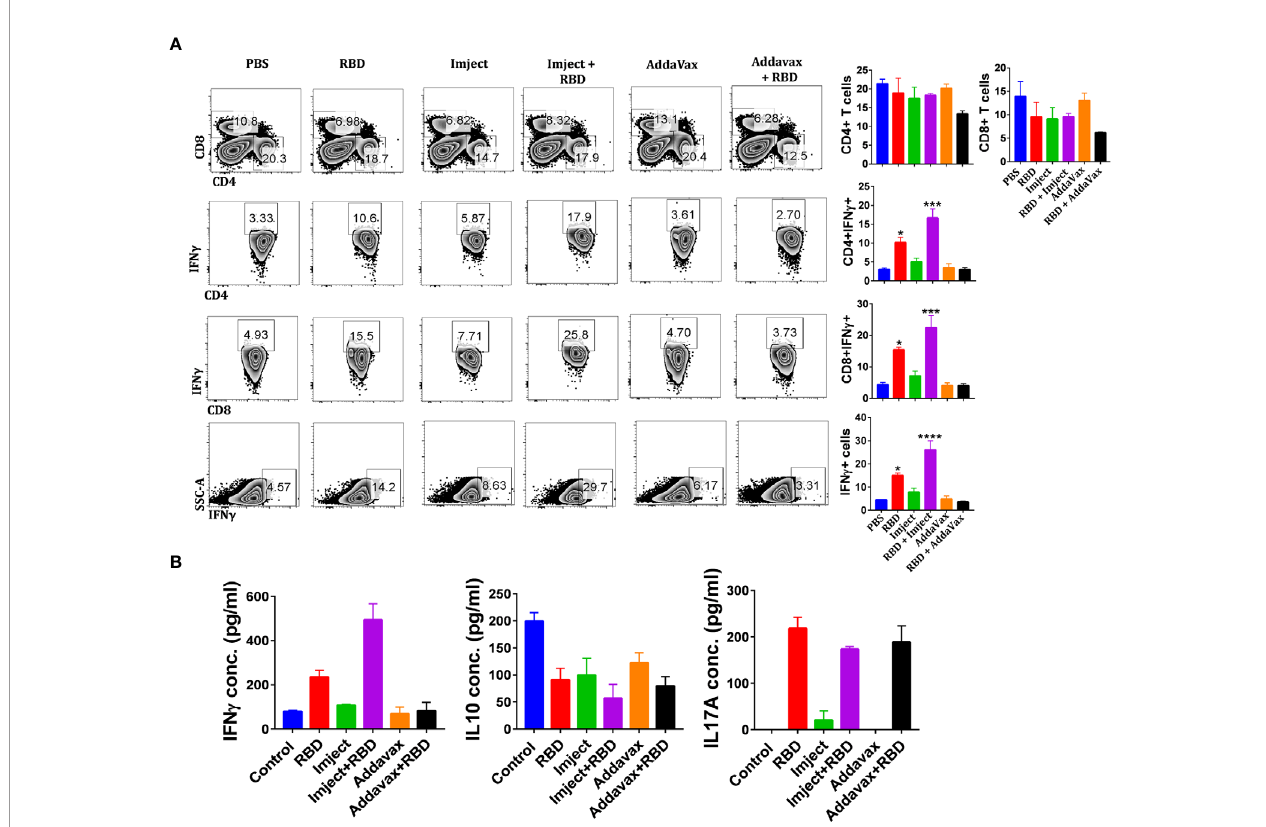
FIGURE 6 | Assessment of antigen-speci fi c cellular immune responses. (A) Splenocytes harvested 14 days post second boost were used for the T cell response studies. In vitro antigen-speci fi c (RBD) stimulated splenocytes were used for intracellular cytokine staining of IFN g , IL-2, and IL-17A cytokines after CD4 and CD8 surface staining. Stained cells were acquired on BD FACSCanto II and analyzed on FlowJo. (A) The contour plots (left panel) indicating mean percent positive values for various T cell populations in the antigen-stimulated splenocytes. Representative bar graph (left panel) plotted for percent of positive ± standard errors of the mean (SEMs) for each group. (B) Sandwich ELISA of IFN g , IL-17A, and IL-10 cytokines of the in vitro RBD-stimulated culture soup was quantitated by using anti-mouse IFN g , IL-17A, or IL-10 primary and secondary antibodies. Statistical signi fi cance was determined using the one-way ANOVA test (p < 0.05). where *p < 0.05, ***p < 0.001, and ****p < 0.0001 (one-way